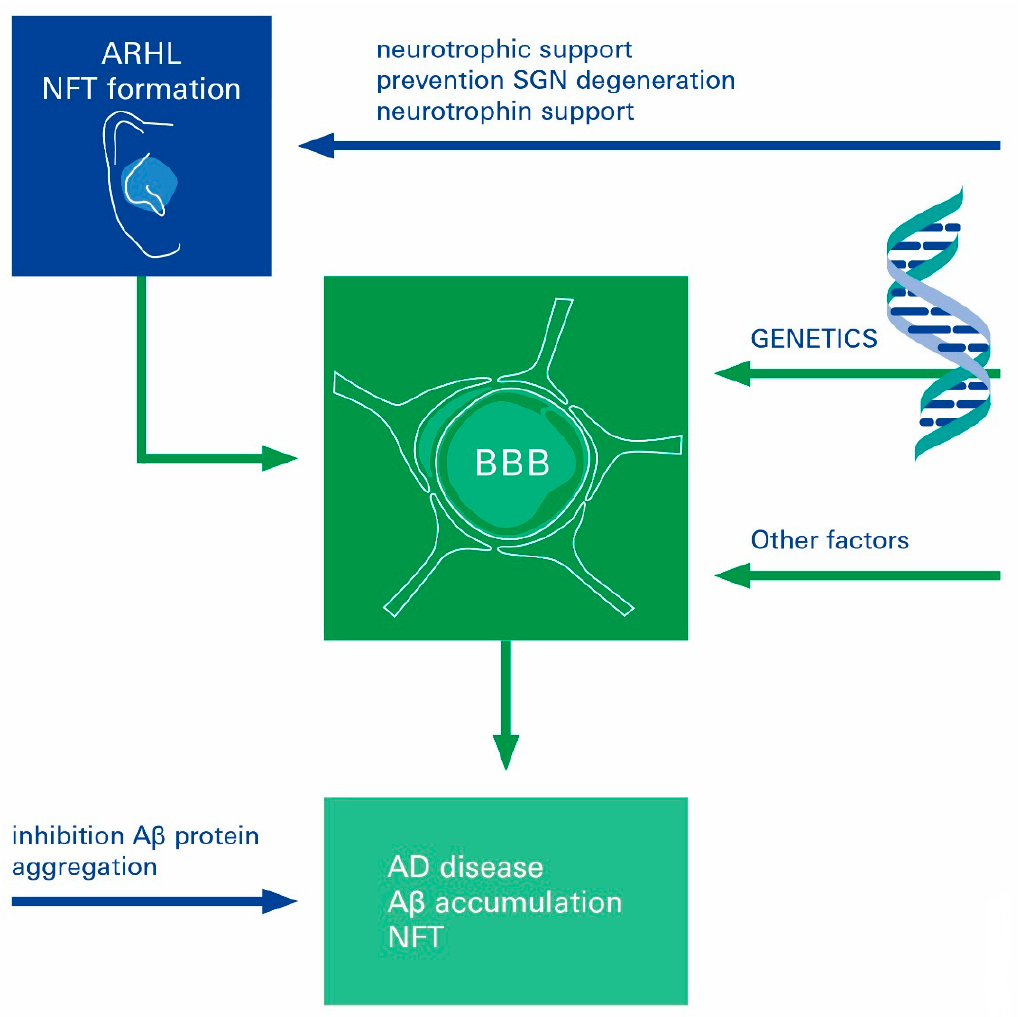
Figure 5. The brain–ear axis linking ARHL to the development of AD. Long before the diagnosis of AD symptoms, AD patients present with clinical signs of a functional defect in the auditory system, and tauopathy is present in the auditory tract. In the era of the epidemiology of increasing longevity, these findings suggest an important new possibility for the early detection and prevention of AD, as the maladies AD and ARHL may coexist and even share a common etiology, rendering AD a systemic disease. Potential intervention points for prevention or therapy by the inhibition of A β protein aggregation or neurotrophic supplementation to nurture and preserve spiral ganglion neurons are indicated by arrows. A β : amyloid‑beta; AD: Alzheimer’s disease; ARHL: age‑related hearing loss; BBB: blood–brain barrier, SGN: spiral ganglion neurons.